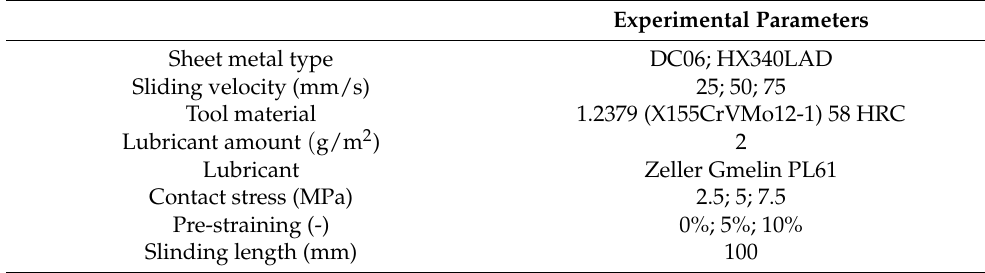
Figure 9. ( a ) Overview: combined strip drawing test; ( b ) schematic illustration of the camera system for the surface observation; ( c ) cross section of tools; ( d ) investigated test surface and tool geometry. Table 4. Experimental parameters for strip drawing tests.